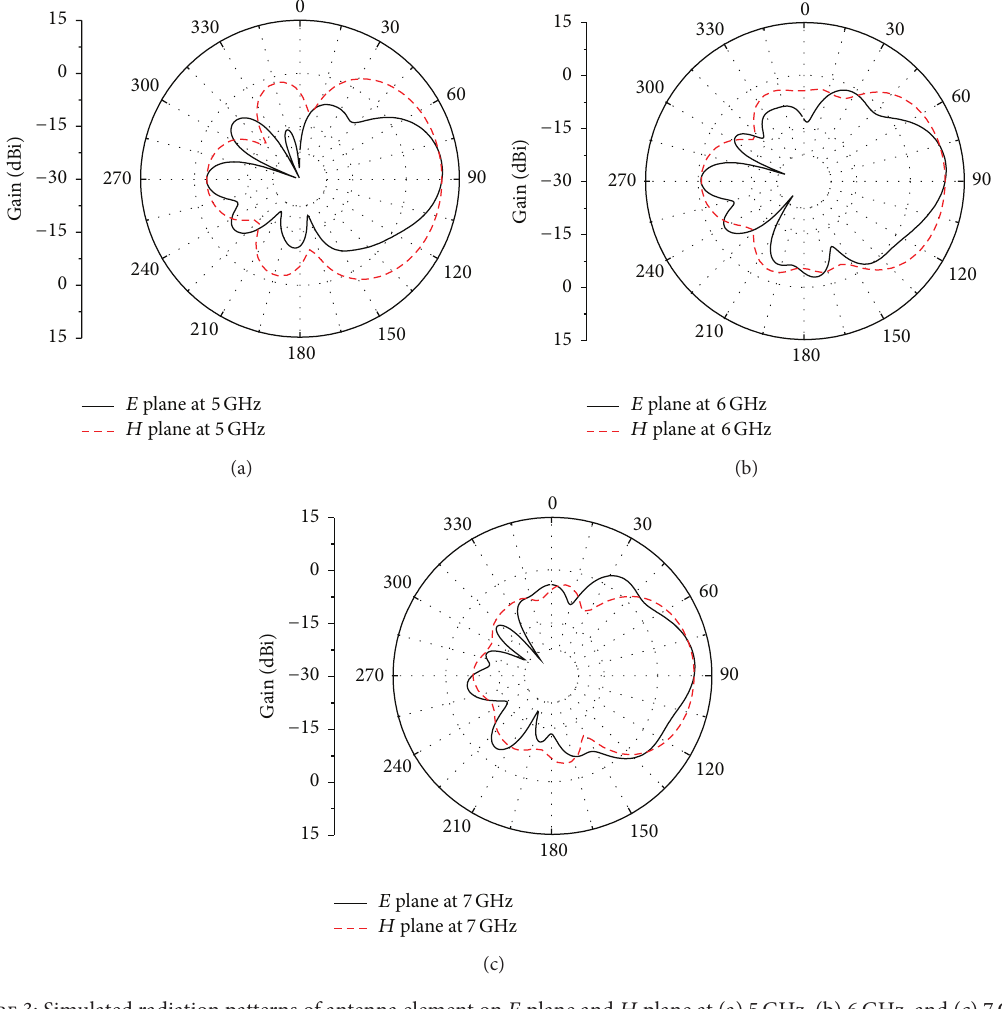
Figure 3: Simulated radiation patterns of antenna element on 𝐸 plane and 𝐻 plane at (a) 5GHz, (b) 6 GHz, and (c)